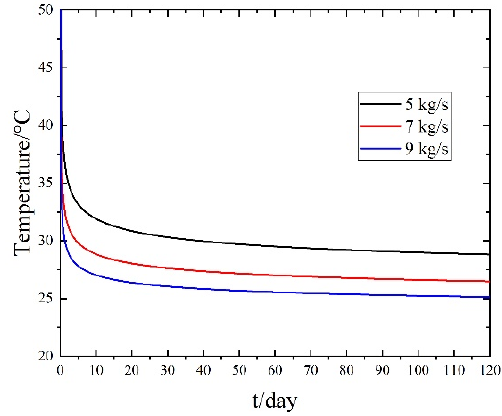
Figure 5. Outlet temperatures of 5, 7 and 9 kg/s.